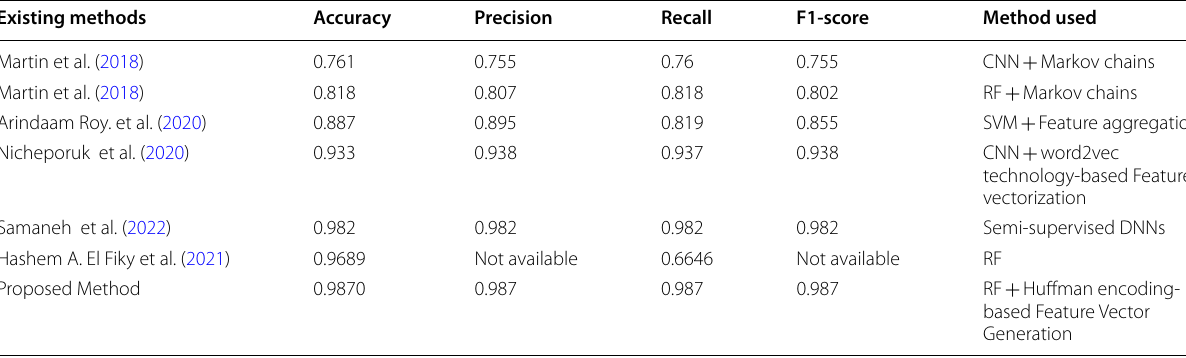
Table 7 Performance comparison of the proposed system with previous methods